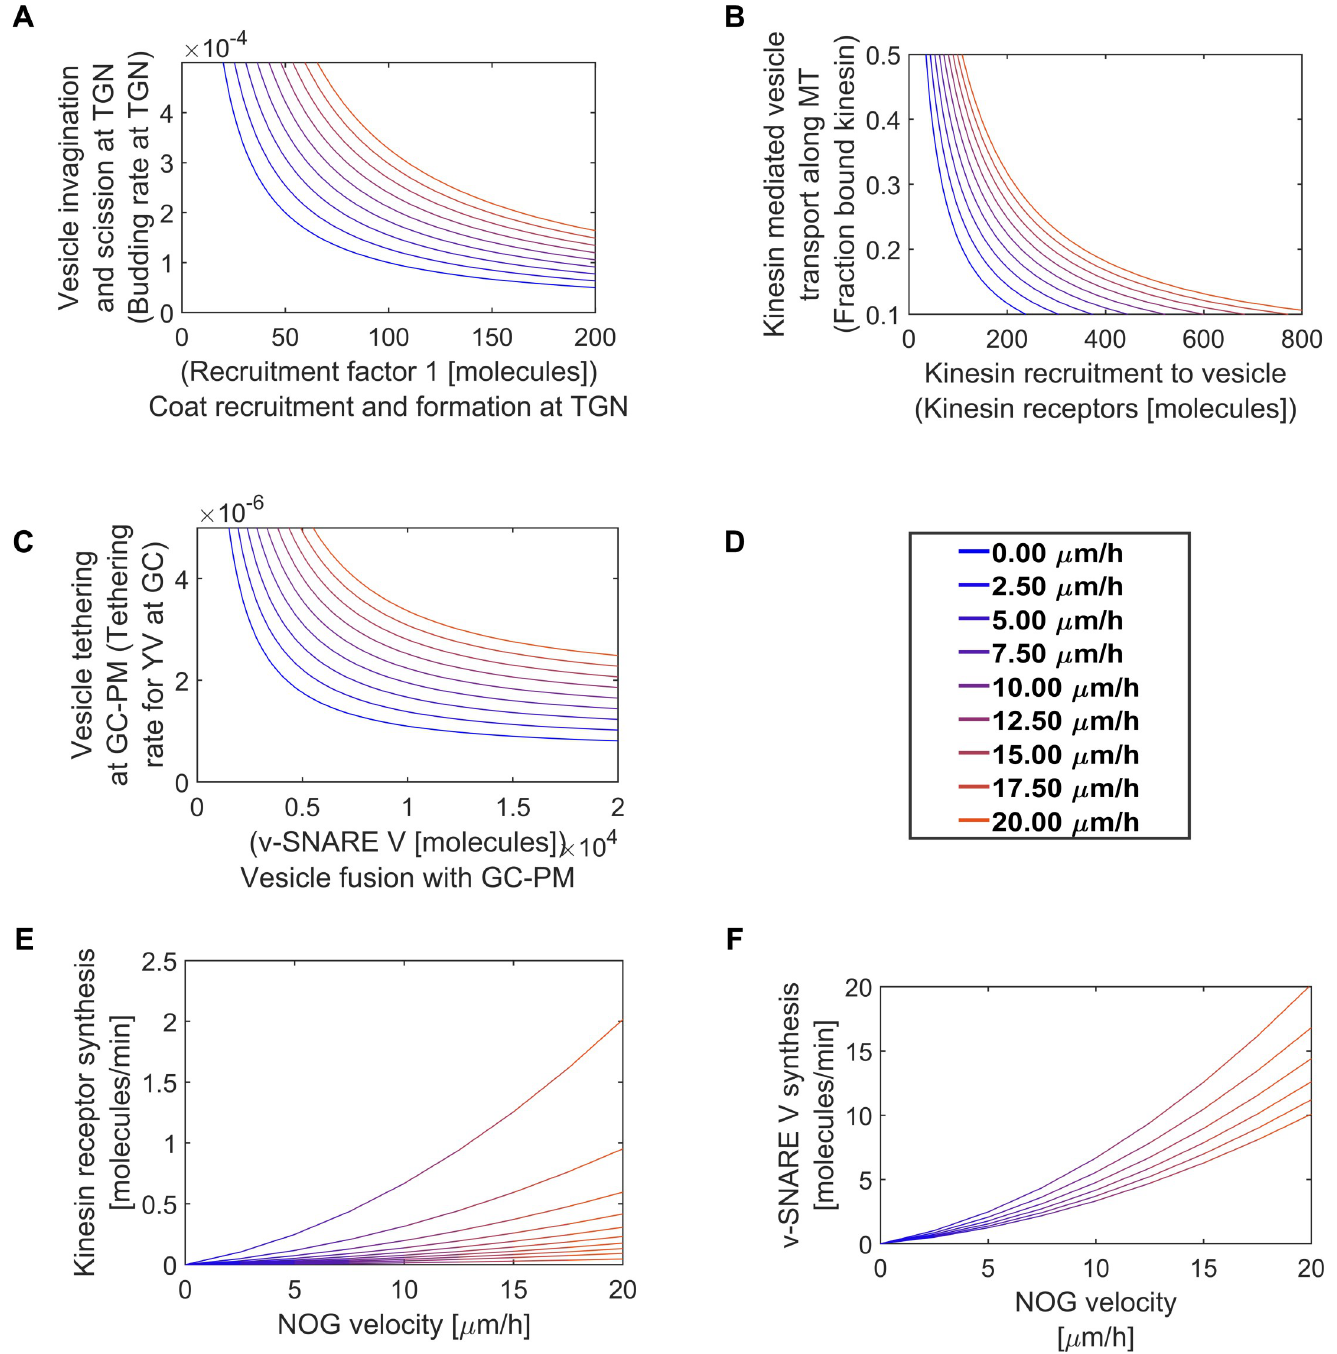
Fig 6. Redundancies among vesicle transport level-3 sibling SCPs. To analyze the relationships between Level-3 SCPs, we used our analytical solution to predict steady state dynamics that enable neurite outgrowth for specified velocities. (A), (B) & (C) Level-3 SCPs show complementary relationships between their activities to generate higher level SCP function without violation of the model constraints. (A) Different activities of the SCPs Coat Recruitment and Formation at TGN and Vesicle Invagination and Scission at TGN were modeled by changing the amount of Recruitment Factor 1 and the budding rate at the TGN. SCP activities were inversely related and increased with increasing velocity. Line colors indicate selected velocities as shown in (G). (B) A similar SCP redundancy was observed for the SCPs Kinesin Recruitment to Vesicle (simulated by # number of kinesin receptors) and Kinesin Mediated Vesicle Transport along the MT (simulated by fraction of bound kinesin). (C) Inverse relationship between SCP activities was also observed for the SCPs Vesicle Tethering (simulated via the tethering rate at the GC) and Vesicle Fusion (simulated by amount # of v-SNARE V). (D) Velocities were color coded in each figure as indicated. (E) & (F) The more a Level-2 SCP activity is generated by a Level-3 SCP that contains a vesicle membrane protein, the higher the SCP activity of membrane protein production to compensate for the loss of membrane protein in the growing NSC reservoir. (E) In dependence of the selected fraction of MT-bound kinesin, vesicles need a different amount of kinesin receptors to ensure NOG without violation of the model constraints. A higher kinesin receptor concentration per vesicle directly translates into the need for a higher